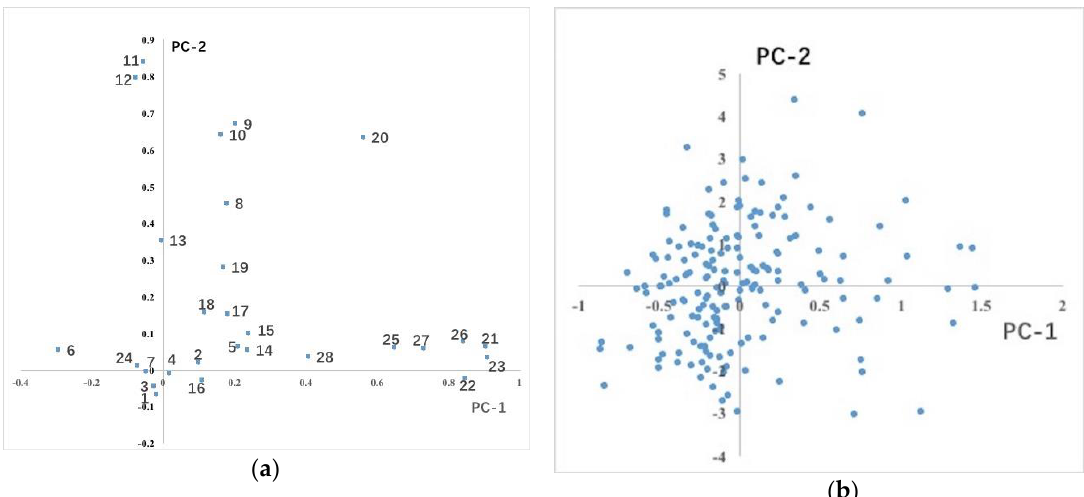
Figure 3. Principal component (PC) coordinate distribution of traits and accessions: ( a ) Distribution of 28 quantitative traits of the population on the PC-1 and PC-2 axis. The traits corresponding to the serial number are shown in Table 1. ( b ) Distribution of 180 accessions on the PC-1 and PC-2 axis.